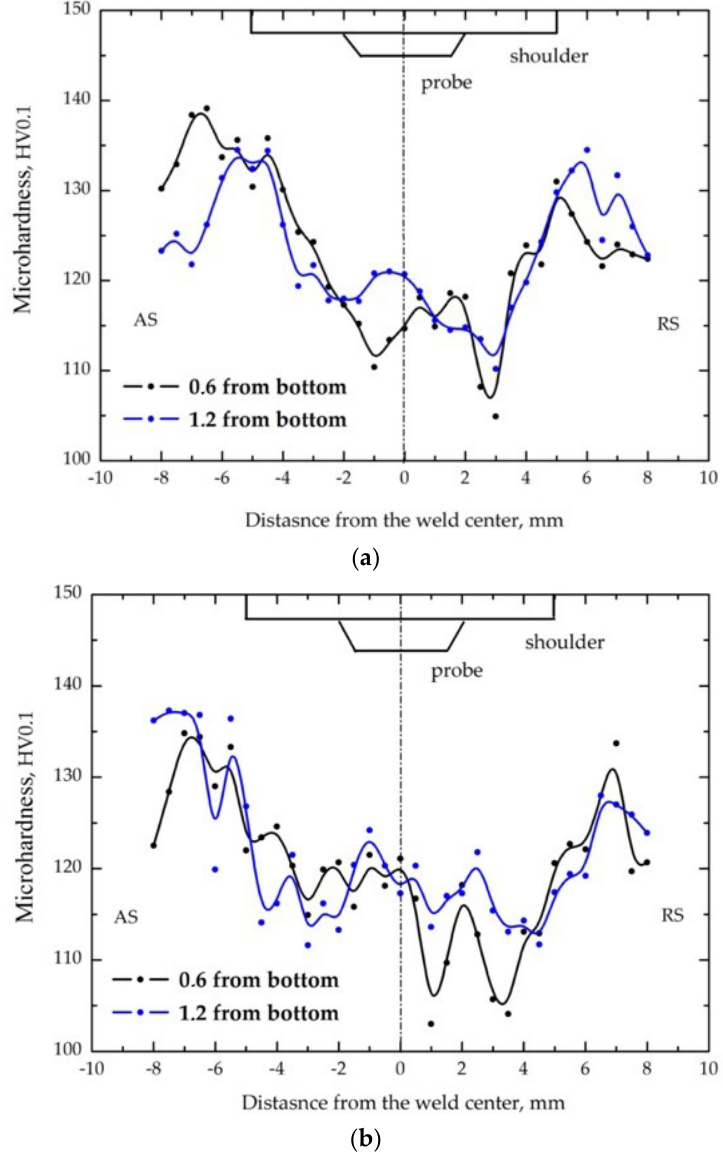
Figure 7. Microhardness profile of the studied joints: ( a ) FSW − C and ( b ) FSW − H.